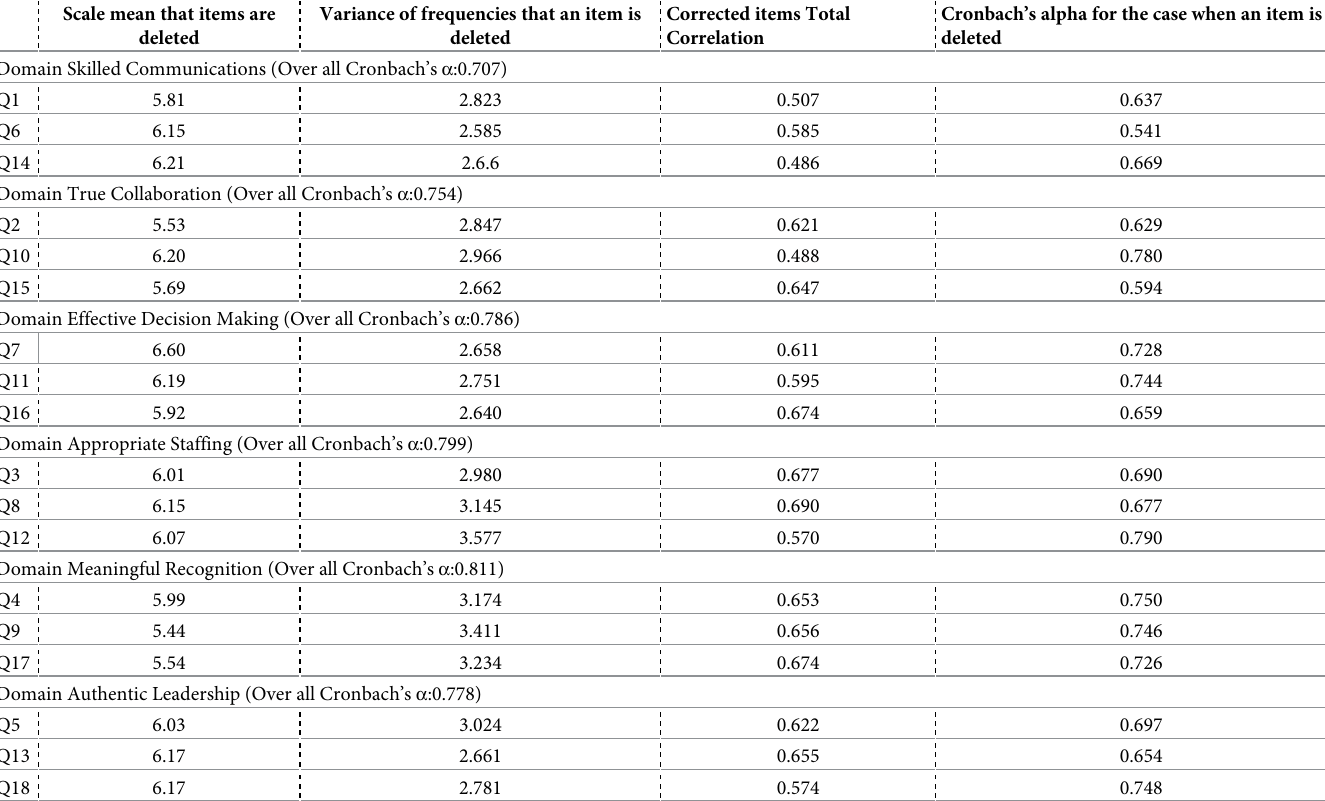
Table 4. Reliability testing: Cronbach’s α . Scale mean that items are Variance of frequencies that an item is deleted deleted